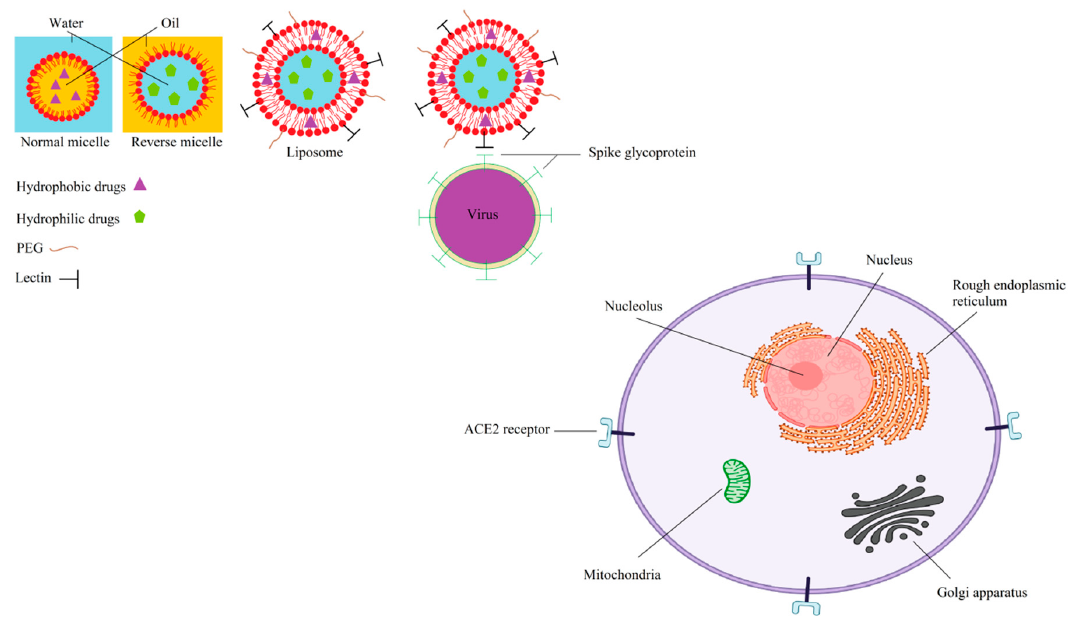
Figure3. Schematicimagesofanormalmicelle, reversemicelle, andliposomewithcommon(PEGylation which is the modification of a protein, peptide or non-peptide molecule by the linking of one or more polyethylene glycol chains) and particular (by lectins) functionalization as well as the interaction of the lectin-modified liposome with spike glycoprotein of virus (only the cell image is extracted from the biorender.com website; the rest are drawn by the